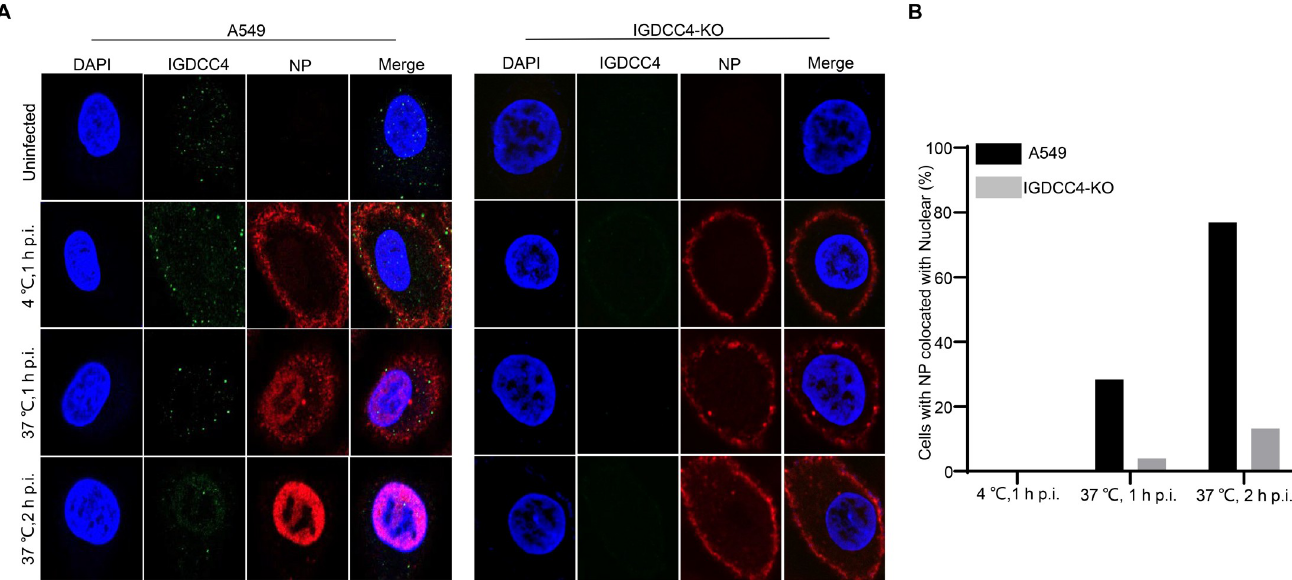
Fig 3. Colocalization of IGDCC4 and viral NP protein in A549 cells and IGDCC4-KO cells infected with H5N1 virus at different timepoints. (A) Cells were infected with H5N1 virus at an MOI of 5 and incubated at the indicated temperature and for the indicated time as described in the text. They were then fixed and stained with a rabbit anti-NP antibody and a mouse anti-IGDCC4 antibody, followed by incubation with Alexa Fluor 633 goat anti-rabbit IgG(H+L) (red) and 488 donkey anti-mouse IgG(H+L) (green). The nuclei were stained with DAPI (blue). ( B ) Quantitative analysis of NP localization in virus-infected cells. The ratio of cells showing colocalization of virus NP and nucleus was calculated from 100 virus-infected